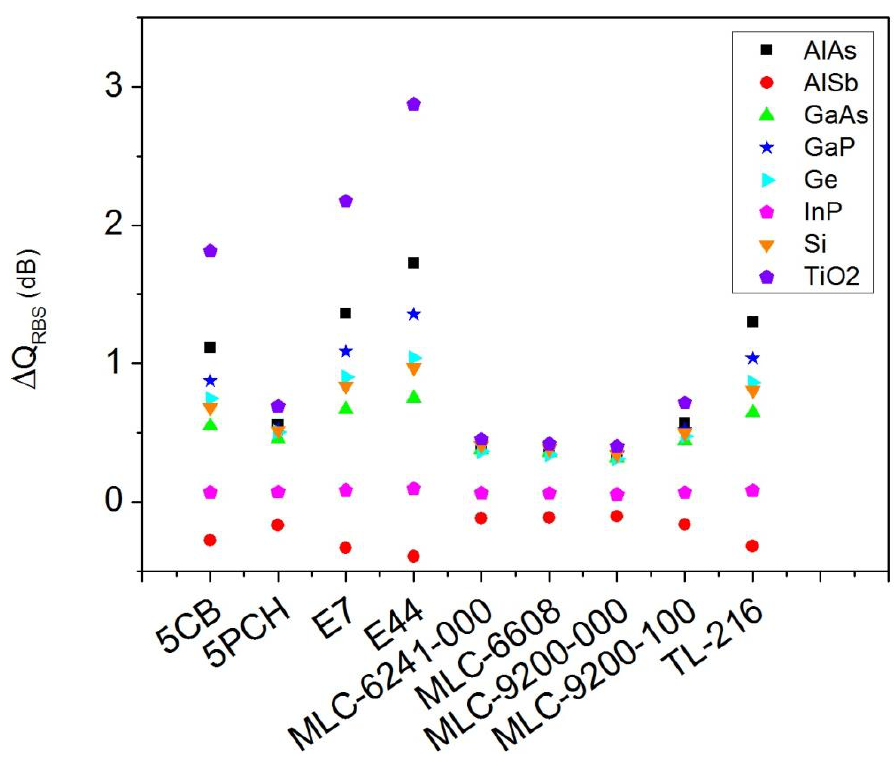
Figure 4. Variation of the radar backscattering efficiency ( Q particle of R = 100 nm embedded in a LC that changes its refractive index from the ordinary to the extraordinary value versus the surrounding LC. The incident wavelength satisfies the minimum-forward scattering condition when the LC presents the n semiconductor materials are